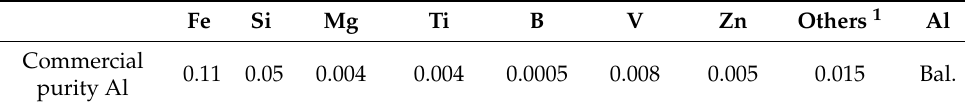
Table 1. Chemical compositions of commercial purity Al